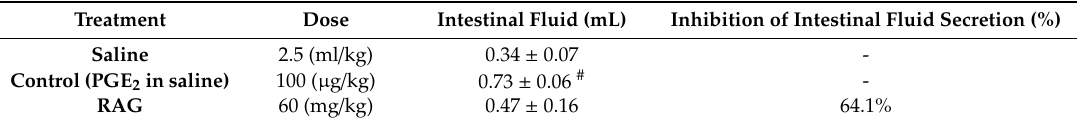
Table 4. E ff ects of red angico gum (RAG, 60 mg / kg p.o.) on PGE 2 -induced intestinal enteropooling and fluid accumulation in